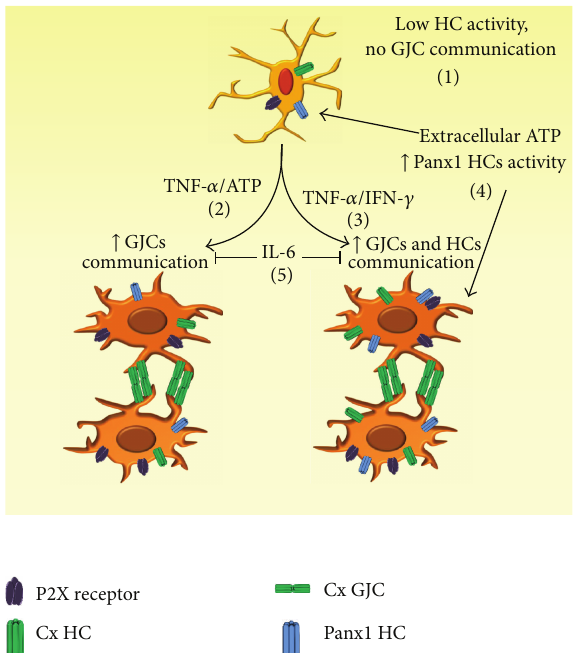
Figure 8: Cytokine-induced activation and the effect on gap junctional communication and HCs activity in cultured microglia. (1) Under resting condition, microglia express P2X receptors, Cx43, and Panx1, which have a low activity. Furthermore, no gap junction channel (GJC) communication is observed. (2) After TNF- 𝛼 plus ATP exposition activated microglia exhibit gap junctional communication, but not intercellular communication mediated by hemichannels (HCs). (3) However, treatment with TNF- 𝛼 /IFN- 𝛾 increased both GJC and HC functional state. (4) Extracellular ATP increases the Panx1 HC activity in both, resting or TNF- 𝛼 /IFN- 𝛾 -activated microglia. (5) IL-1 𝛽 release from activated microglia favors gap junctional communication. (6) IL-6 prevents IL-1 𝛽 release and the increase in GJC and HC functional